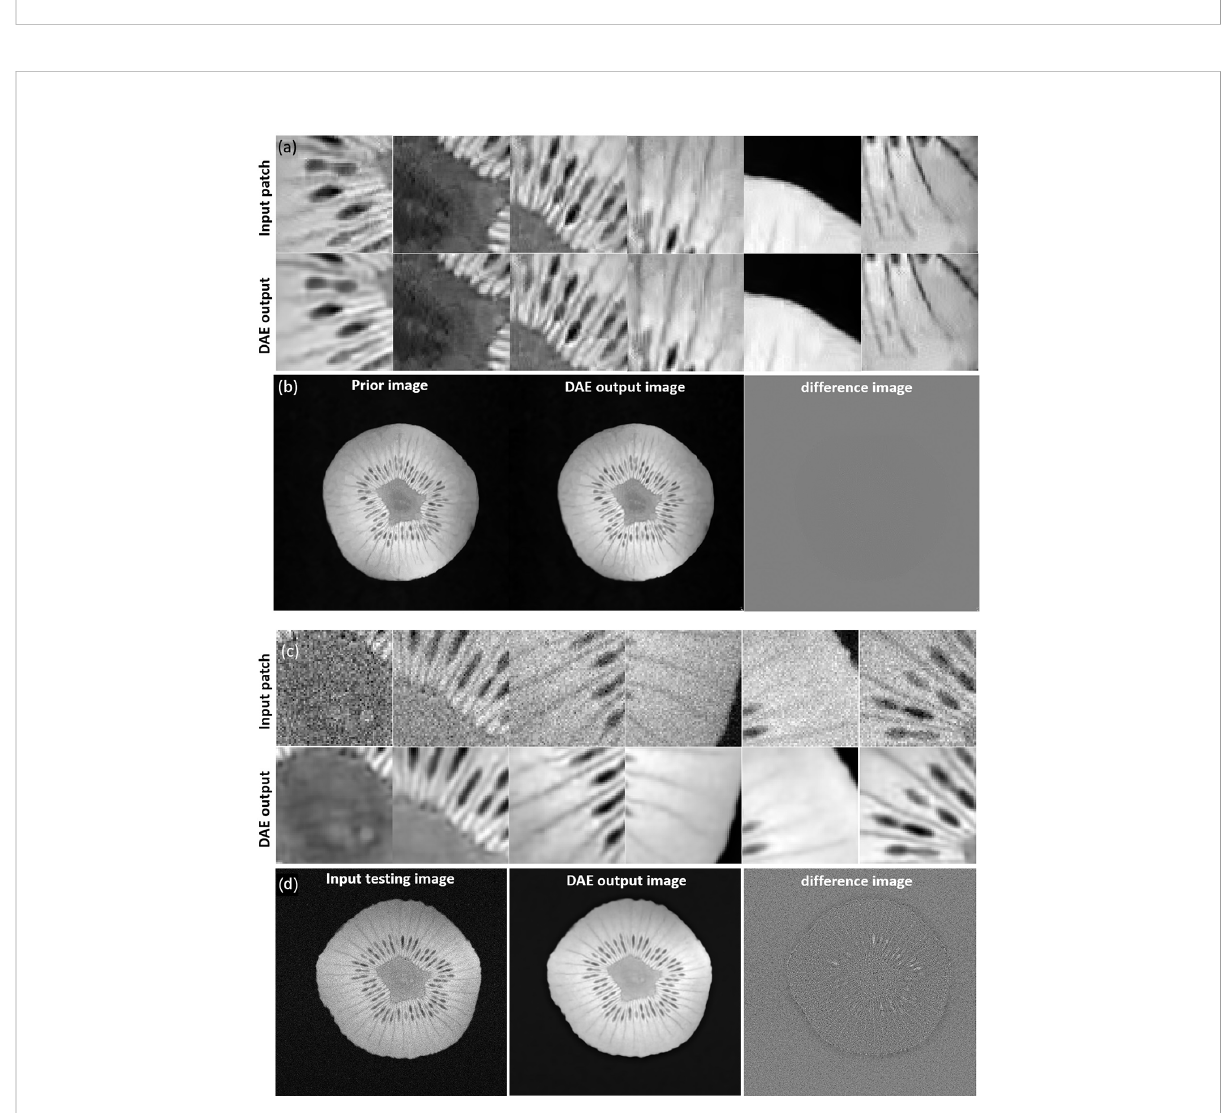
FIGURE 10 (A) Input and output patches of the DAE for the prior kiwi image. (B) Prior Kiwi image, the image assembled by patches from DAE output, and their difference image. (C) Input and output patches of the DAE for a testing kiwi image. (D) A testing Kiwi image, the image assembled by patches from DAE output, and their difference images. All the MR patches and images are displayed in a window of [0, 1], while the difference images are displayed in a window of [-1,